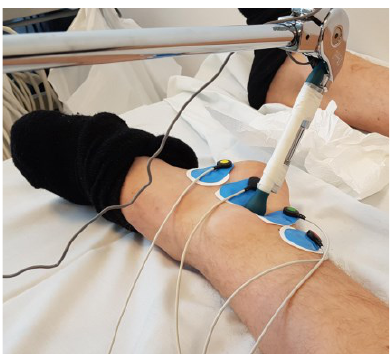
Figure 1: Illustration of posterior tibial artery with the tonometer between the four